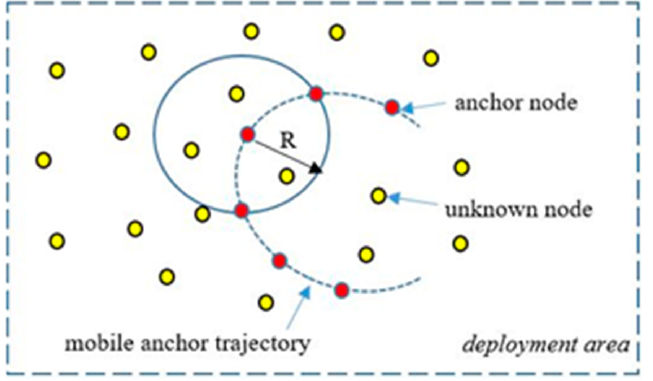
Figure 1. Mobile anchor node assisted localization [7].